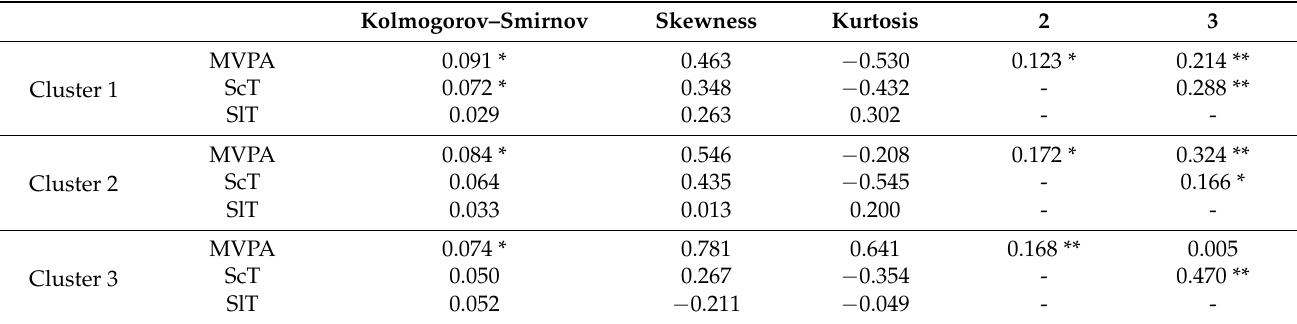
Table 7. Descriptive statistics and correlations between variables in each